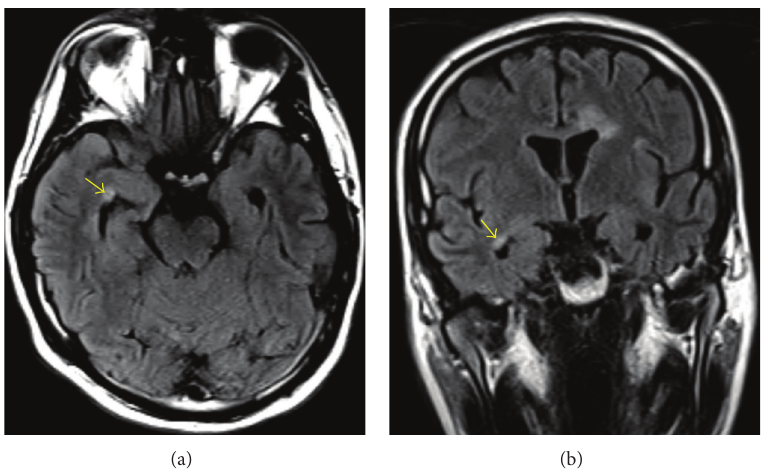
Figure 2: Follow-up cranial MRI showing (a) axial and (b) coronal T2-weighted FLAIR view of the new demyelinating lesion in the right temporal white matter